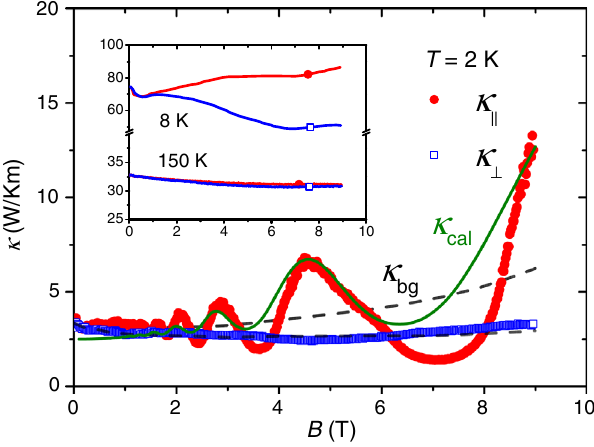
FIG. 4. Ultrasound velocity (left) and the corresponding ultra- sound echo amplitude (right) measured as a function of the field at T ¼ 2 K. A transverse sound of 19 MHz is used, with the propagation ð k Þ and polarization ð u Þ along the c and a axes, respectively (see the inset). The detected sound velocity is approximately 2010 m = s, as expected for the transverse acoustic phonons of TaAs [32]. These measurements are performed under the condition that the ultrasound propagation and magnetic field are parallel and along the c axis, corresponding to the field configuration for κ k ð B Þ measurements. The dominating oscilla- tions in both quantities have a frequency of 7 T, almost in phase with κ k ð B Þ MQOs; see Fig. 2(b). The quantum oscillations of the sound velocity are of the order of 1 = 10 4 up to 9 T, whereas the corresponding echo amplitude oscillates within 5% of its zero field value. The dashed blue line indicates the decreasing back- ground of the ultrasound echo amplitude as a function of B , which implies a decreasing phonon mean-free path.